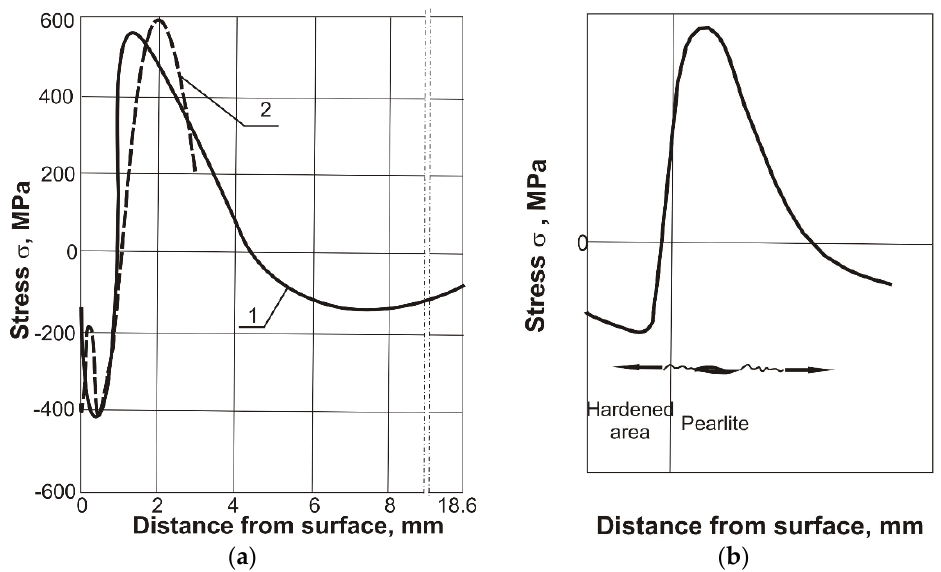
Figure 6. ( a ) Distributions of circumferential residual stresses in induction hardened 41Cr4 specimen to a depth of 2.3 mm (1) based on [26] and in cutting edge of 40 mm wear-resistant steel plate ( 2 ) based on [19]; ( b ) scheme of crack development under the thermally cutting surface.